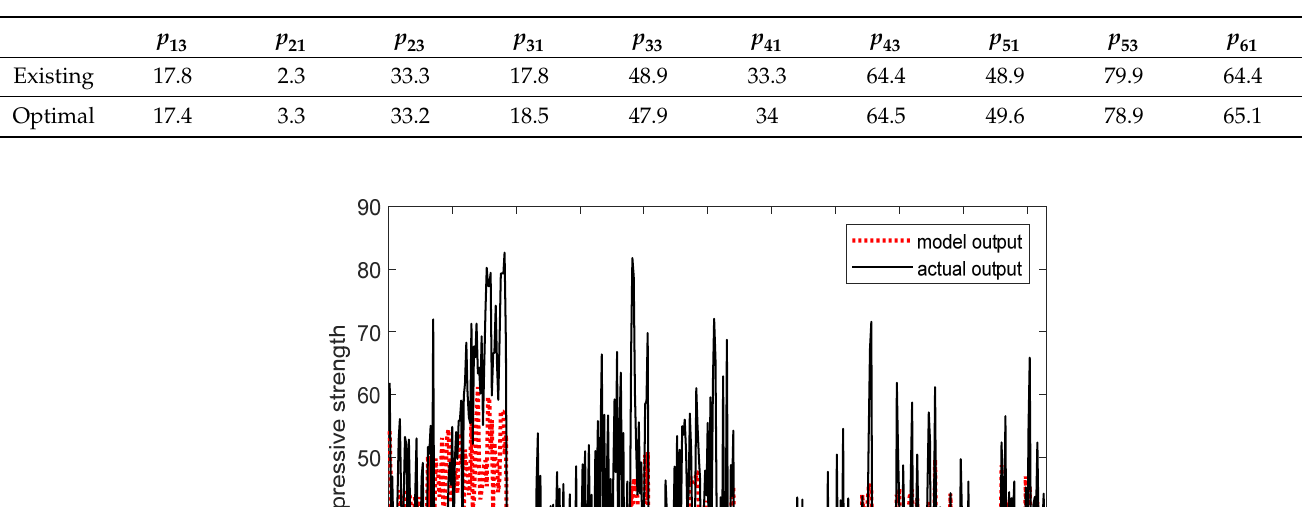
Figure 14. PI of the optimized CGK-based fuzzy granular model.